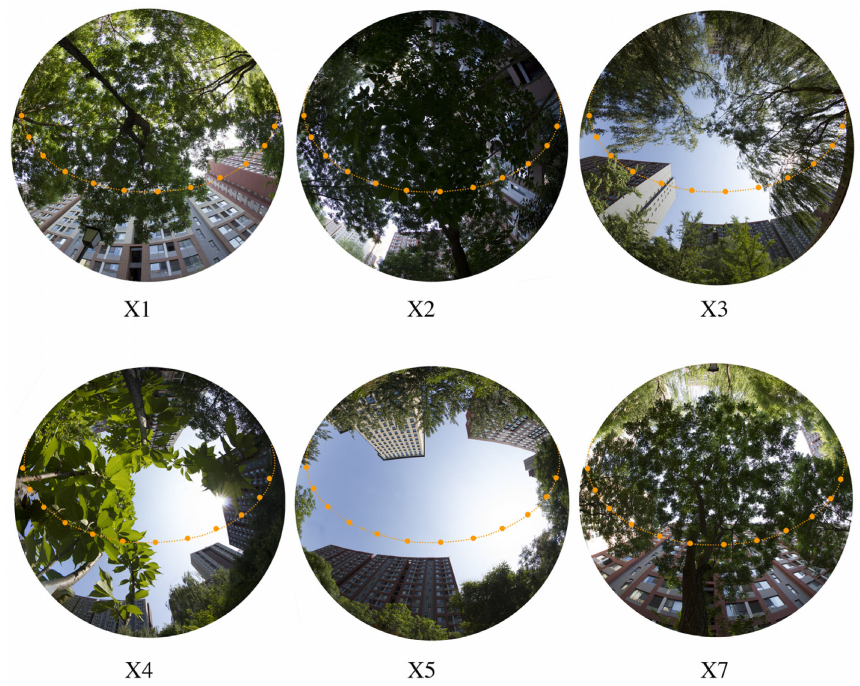
Figure 11. Fisheye photos of six observation points in Xueqing Estate. Table 5. Average Ta and shading characteristics of six observation points in Xueqing Estate